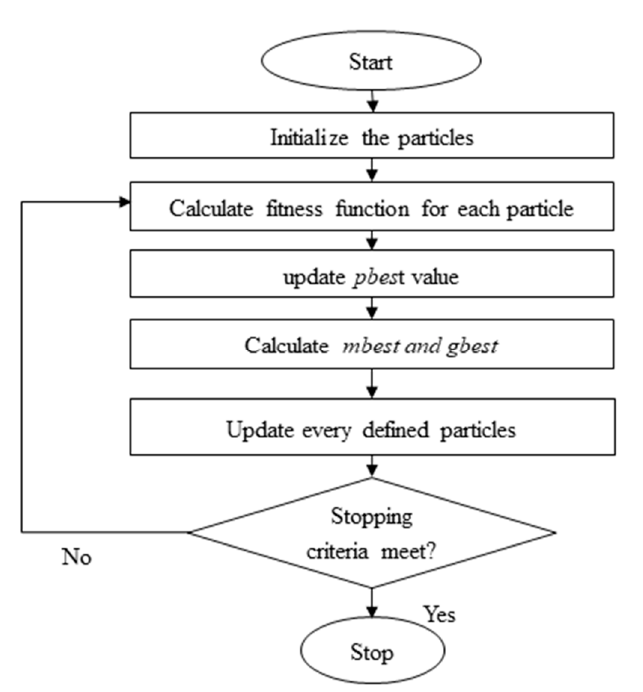
Figure 2. Flowchart of quantum particle swarm optimization (QPSO).